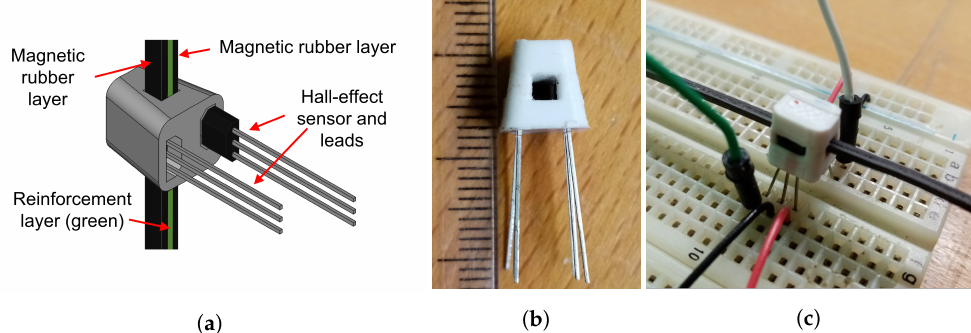
Figure 7. Encoder housing and single sensor setup: ( a ) 3D rendering with SS49E sensors; ( b ) housing implementation in PLA material (scale in mm); ( c ) experimental set up for single sensor tests.